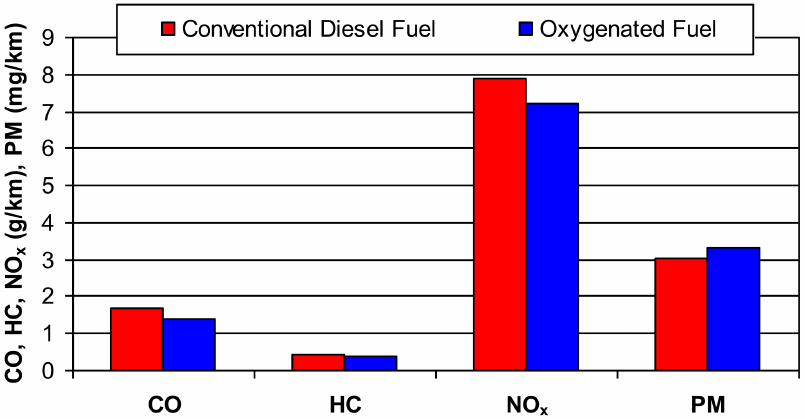
Figure 9. Average road emissions in the SORT 3 cycle from the Solaris Urbino 18 Hybrid bus fuelled by conventional diesel fuel and oxygenated fuel.